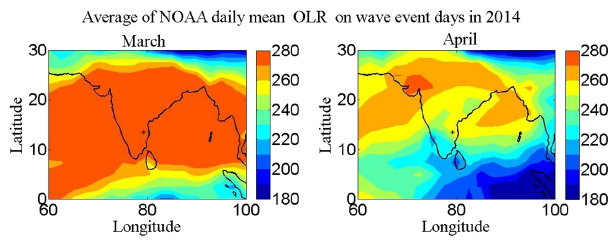
Figure 12. As in Fig. 7 but for the year